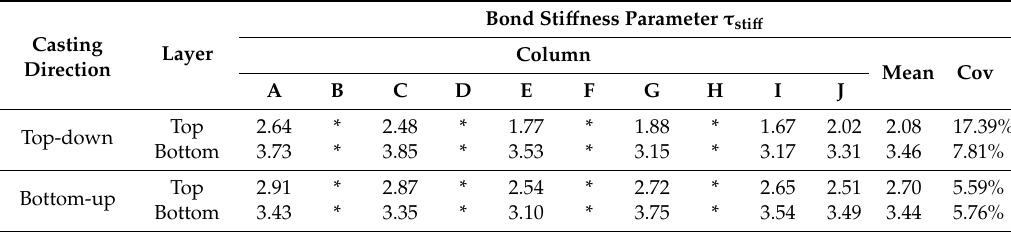
Table 8. Bond sti ff ness parameter for the whole scope of